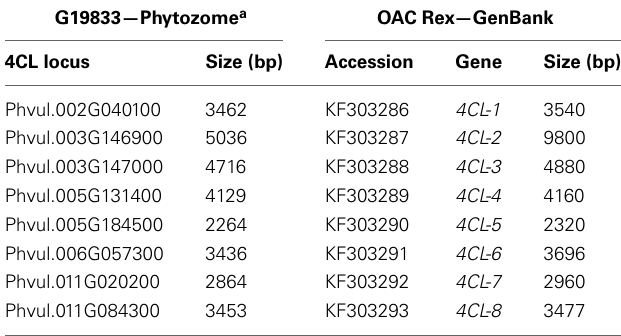
Table 7 | Eight 4CL loci in common bean cultivars G19833 and OAC